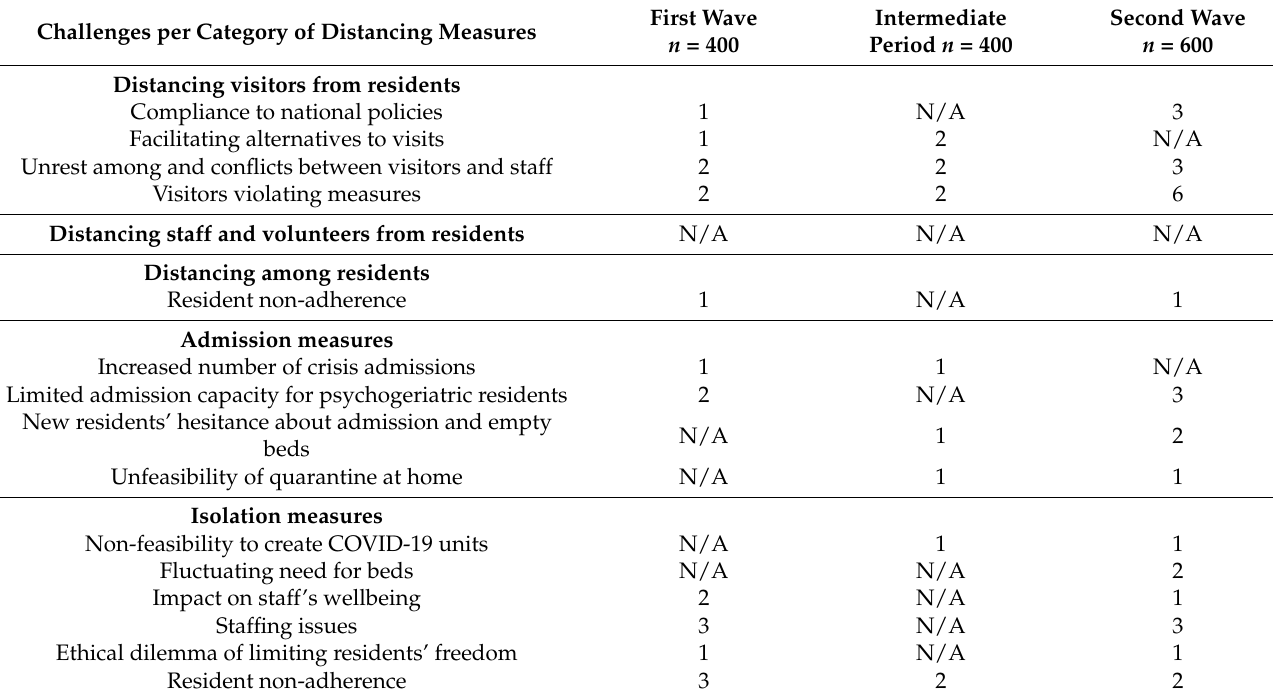
Table 2. Textual units regarding challenges discussed by COVID-19 outbreak teams per category of distancing